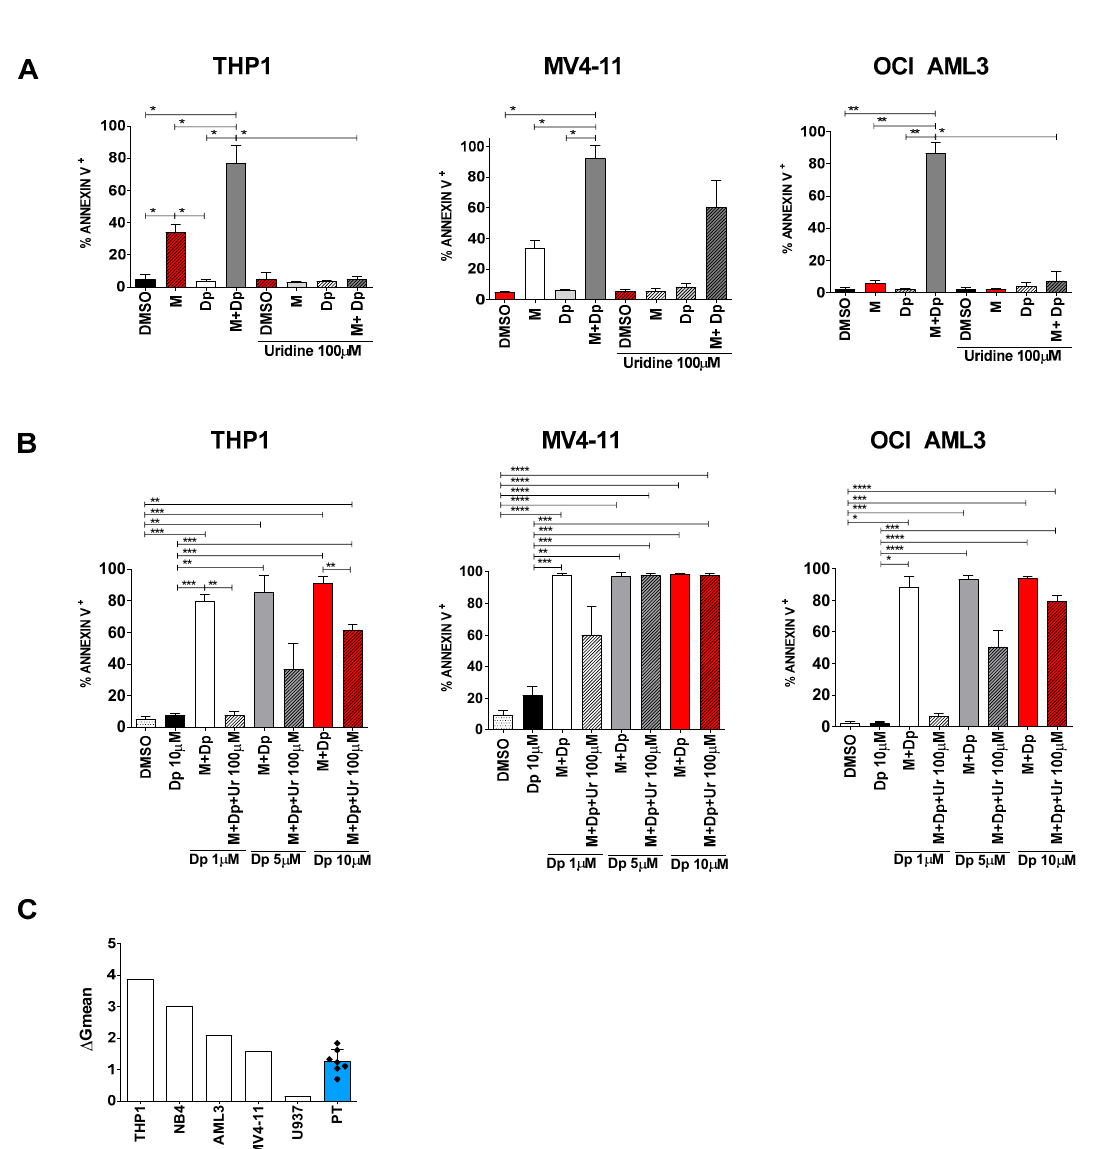
Figure 8. The uridine rescue is influenced by uridine concentrations and by the availability of hENT2 transporters. ( A ) Apoptosis induced by MEDS433, dipyridamole or their combination, with and without uridine at 100 µM, on THP1 (left panel, n = 3), MV4-11 (middle panel, n = 3) and OCI AML3 cells (right panel, n = 3). Dipyridamole was utilized at the standard dose of 1 µM. ( B ) Apoptosis induced by MEDS433 in combination with increasing dipyridamole concentrations, with and without uridine at 100 µM on THP1 (left panel, n = 4), MV4-11 (middle panel, n = 4) and OCI AML3 cells (right panel, n = 3). ( C ) hENT2 expression levels in utilized cell lines and primary AML cells, assessed by flow cytometry. In all experiments, MEDS433 was utilized at 0.1 µM and apoptosis was evaluated after 3 days of treatment. DMSO: dimethyl sulfoxide. M: MEDS433. Dp: dipyridamole. Ur: uridine. PT: patients. ∆ Gmean: refers to Section 4.6. Statistical significance: Anova/Tukey, * p < 0.05; ** p < 0.01; *** p < 0.001, **** p <